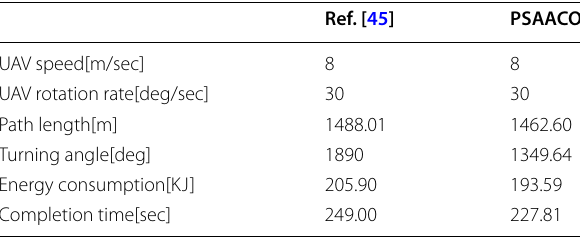
Table 9 Experiments for Performance Comparison between PSAACO and algorithm in [45]